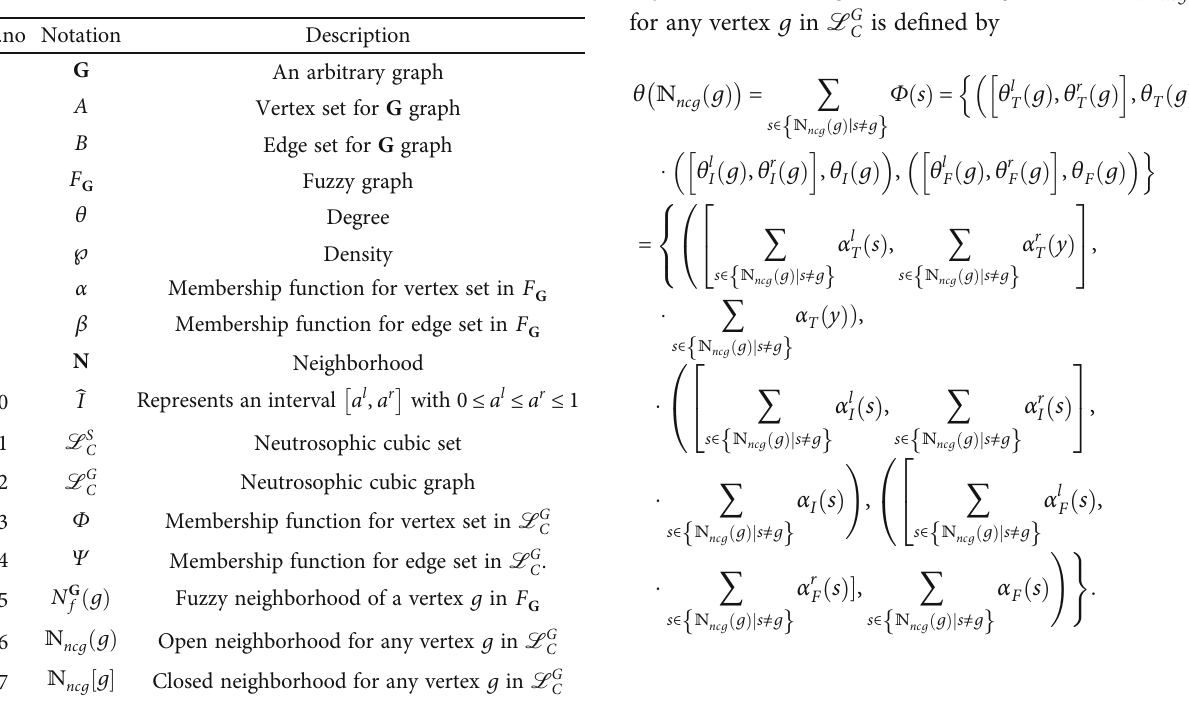
Table 1: Notations and their